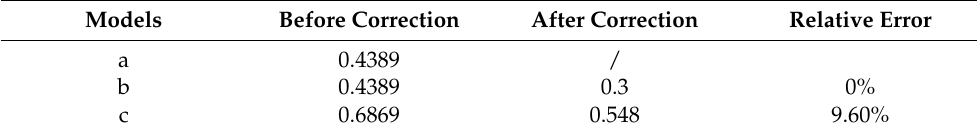
Figure 12. Synthetic data of non-homogeneous medium model. Table 3. Inversion results of depth of non-homogeneous medium model.